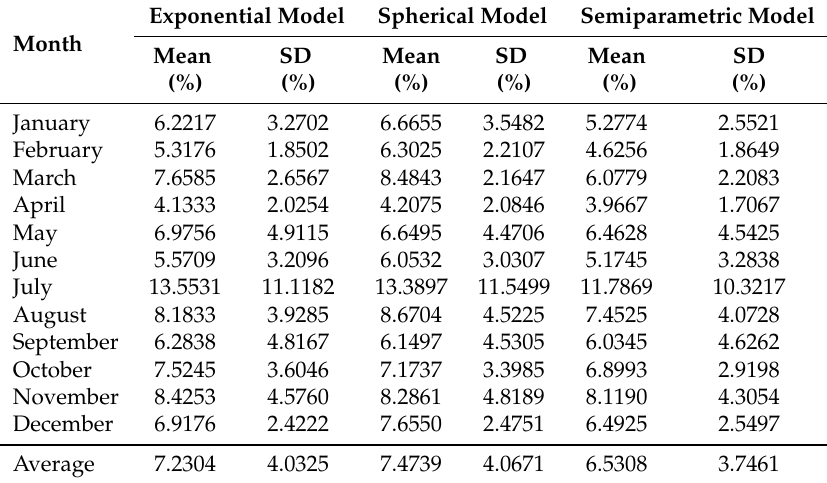
Table 1. The mean and standard deviation of mean absolute percentage error (MAPE) of three semivariograms.